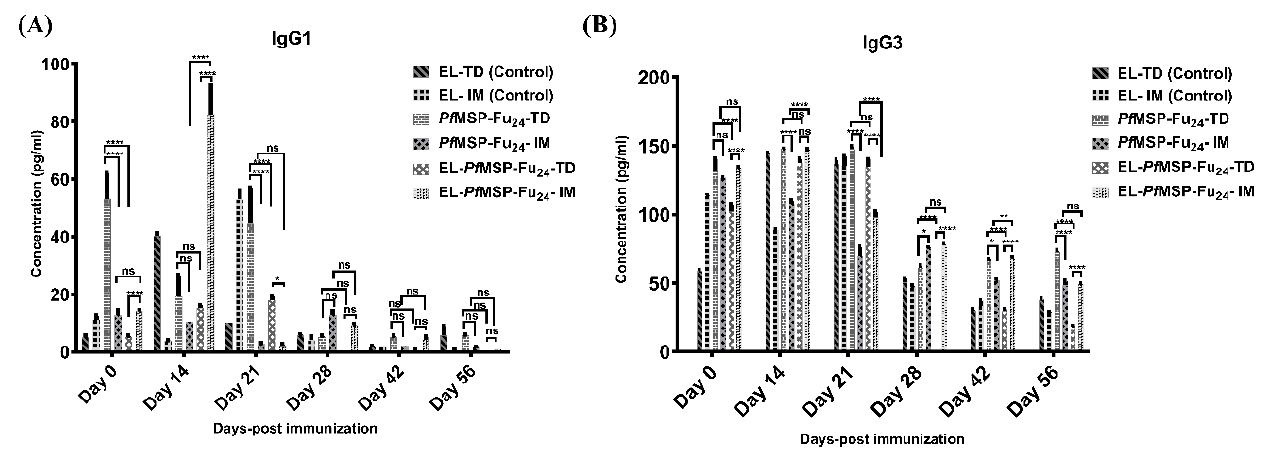
Figure 7. The specific IgG antibody response in mice vaccinated with plain Pf MSP-Fu 24 and Pf MSP-Fu 24 -loaded elastic liposomal formulations. The statistical data are expressed as mean ± SE (n = 3 or 5). (* p < 0.05, ** p < 0.01, and *** p < 0.001). ( A ) IgG1 and ( B ) IgG3 isotype subclass of specific antibody (IgG) levels in mice immunized with Pf MSP-Fu 24 antigen formulations. Mean ± SE (n = 6). (* p < 0.05, ** p < 0.01, *** p < 0.001 and **** p < 0.0001).